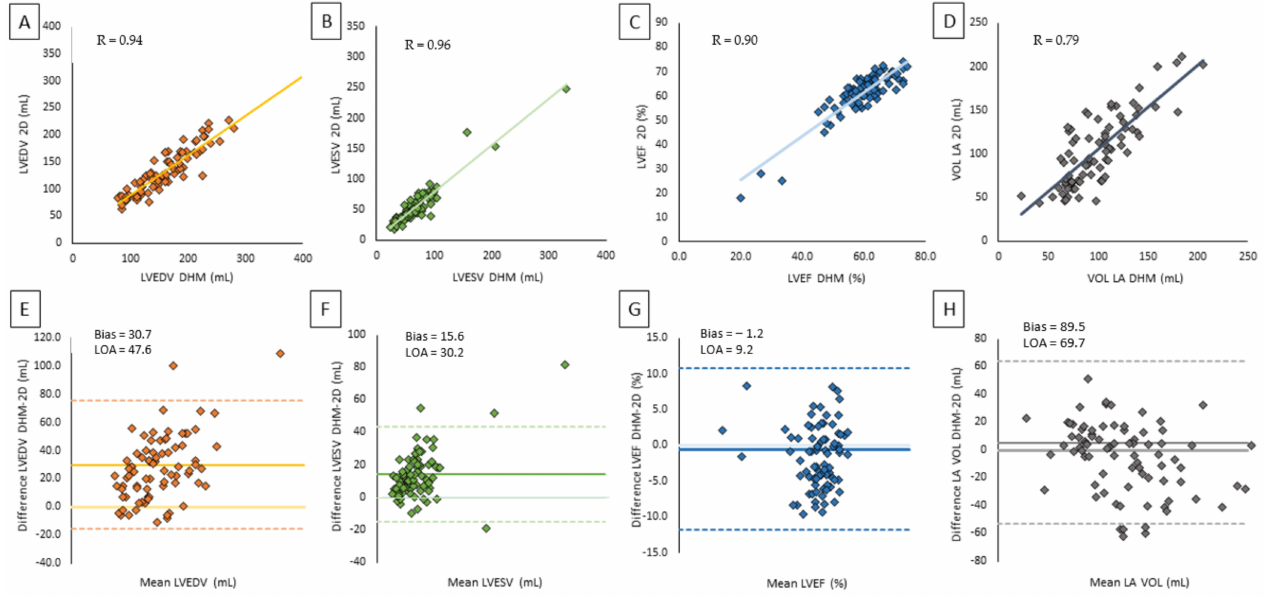
Figure 2. Correlation and agreement between 2D TTE and DHM on left chamber volume and LV function: ( A ) scatter plot of LVEDV by 2DTTE versus DHM, ( B ) scatter plot of LVESV by 2D TTE versus DHM, ( C ) scatter plot of LA volume by 2D TTE versus DHM, ( D ) scatter plot of LVEF by 2DTTE versus DHM, ( E ) Bland–Altman plot of LVEDV by 2DTTE versus DHM, ( F ) Bland–Altman plot of LVESV by 2D TTE versus DHM, ( G ) Bland–Altman plot of LVEF by 2DTTE versus DHM, ( H ) Bland–Altman plot of LA volume by 2D TTE versus DHM.